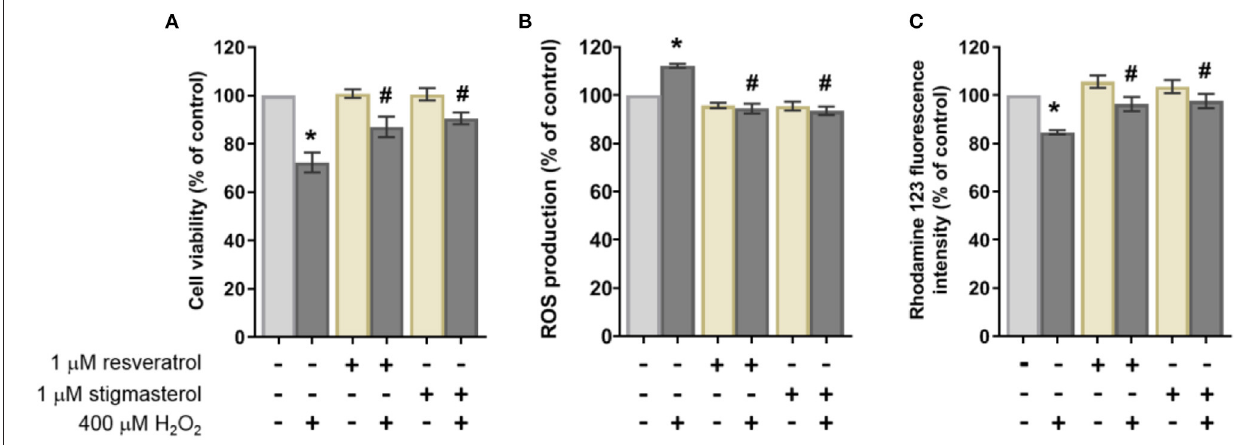
FIGURE 2 | Effects of 1 µ M resveratrol and stigmasterol pretreatment for 3h followed by 400 µ M H 2 O 2 exposure for 24h of SH-SY5Y cells on the (A) cell viability, (B) intracellular ROS production, and (C) mitochondrial membrane potential (MMP) as measured by the Rhodamine 123 fluorescence intensity (% of control). Data are presented as mean ± S.E.M. of three independent experiments (* p < 0.05 vs. control; # p < 0.05 vs. 400 µ M H 2 O 2 -treated group).